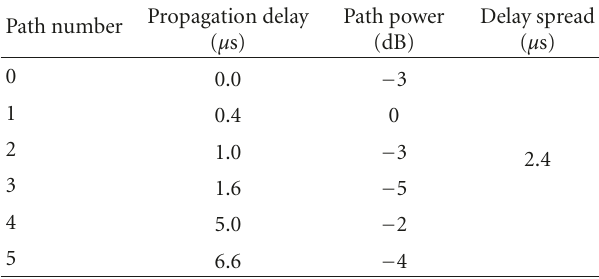
Table 1: COST 207—Bad Urban channel model [46]